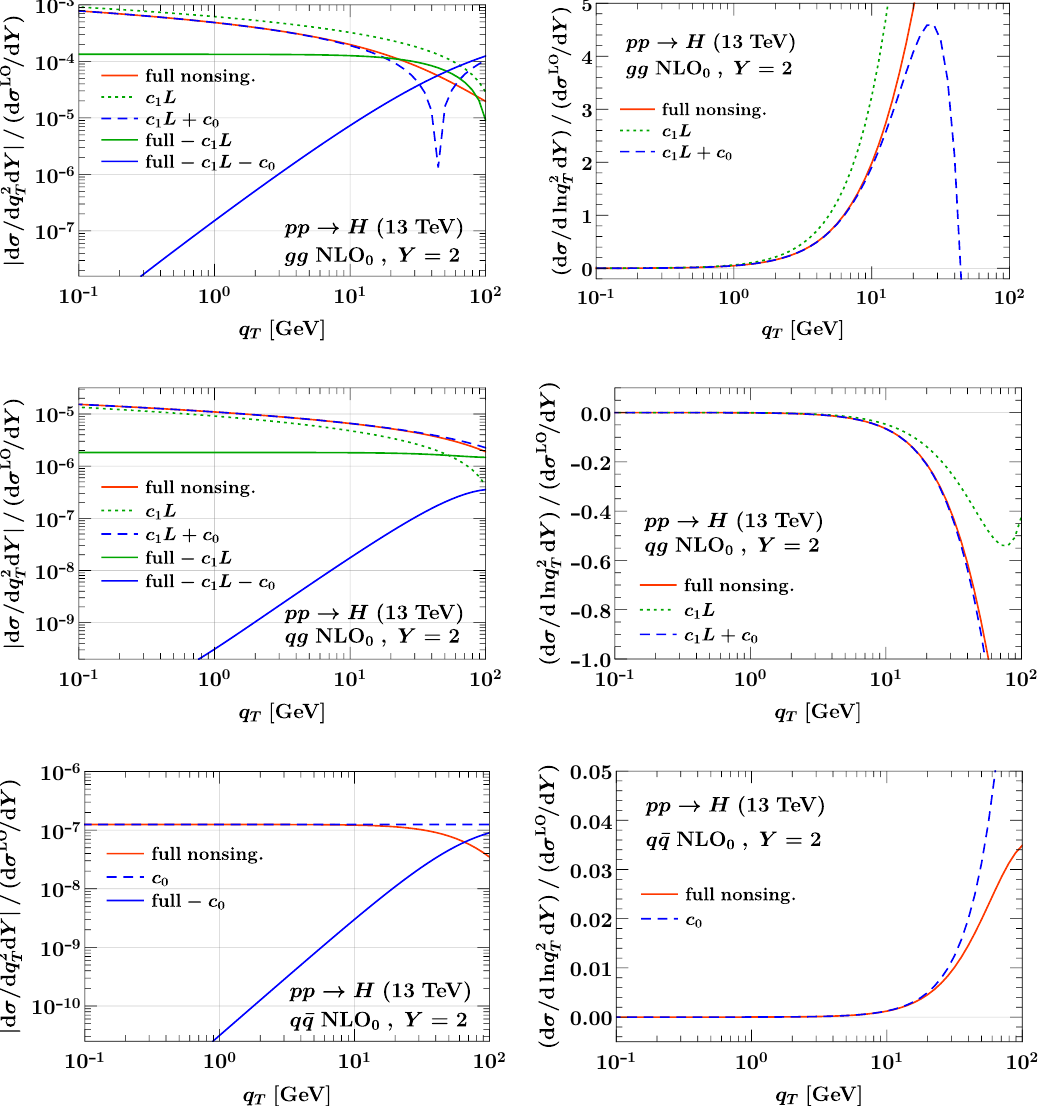
Figure 1 . Comparison of the LL and NLL corrections at subleading power with the full nonsingular q T spectrum for all partonic channels contributing to Higgs production at NLO 0